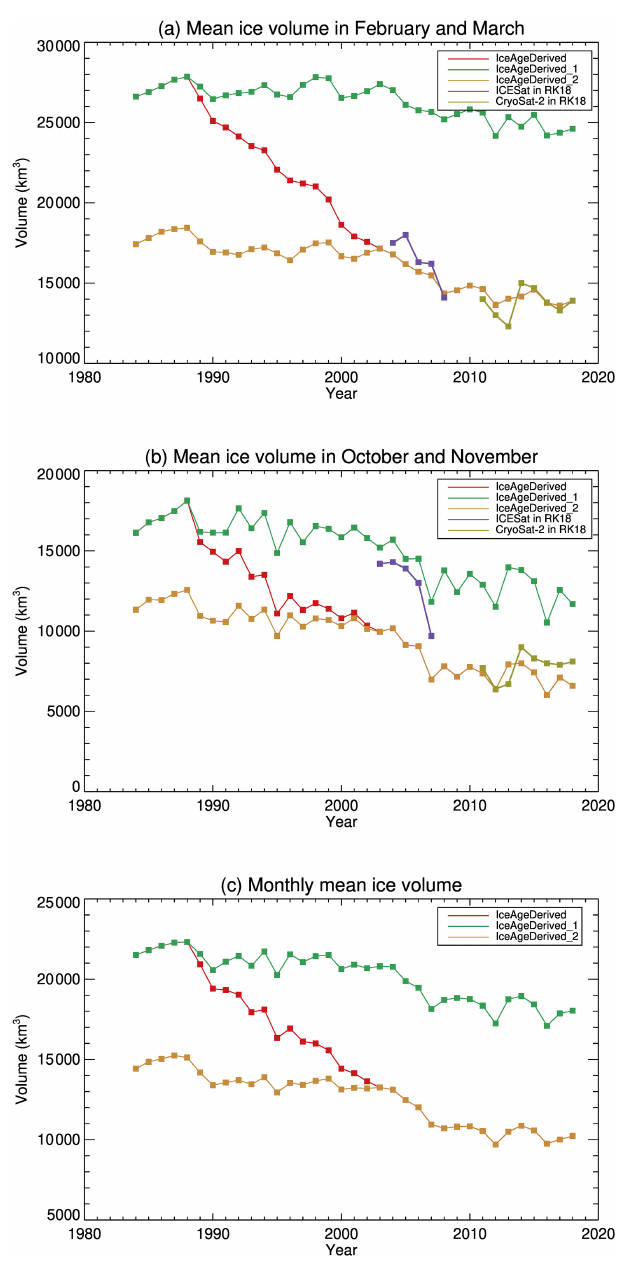
Figure 21. Mean ice thickness over the Arctic Ocean from 1984 to 2018 derived from ice age using a varying age–thickness re- lationship (IceAgeDerived); using the age–thickness relationship in 1984 (IceAgeDerived_1); and using the age–thickness relation- ship in 2004–2008 (ICESat) (IceAgeDerived_2) in (a) February and March, (b) October and November, and the (c) monthly mean of all